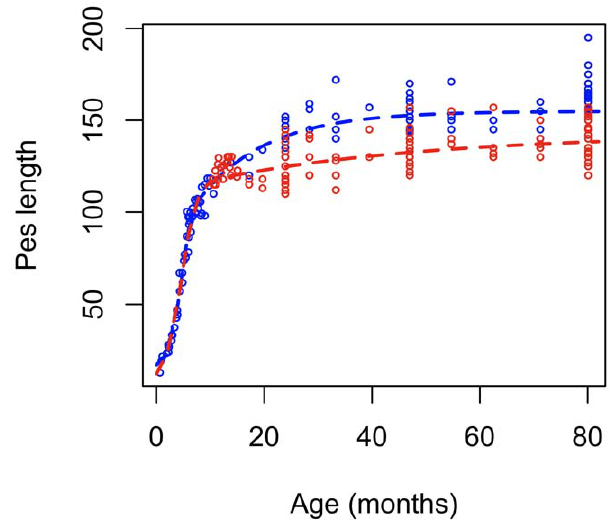
Figure 5. The SJ2P model describes the lifetime growth (pes length) of the Tasmanian pademelon ( Thylogalebillardierii ). Red circles denote female pes length and red dashed line shows the SJ2P model describing growth of females from birth to 80 months of age; blue circles denote male pes length and blue line shows the growth of males from birth to 80